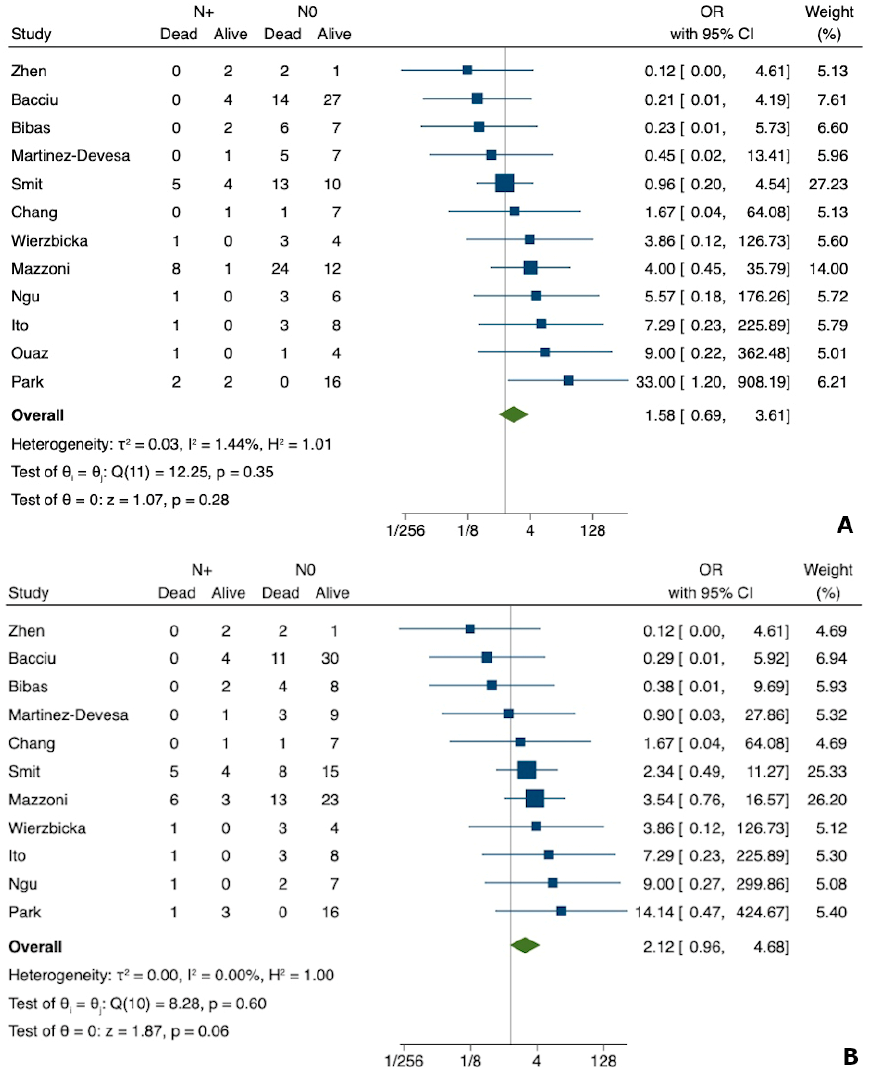
Figure 4. Forest plot for the odds ratio of N status and survival (( A )—overall survival [4,23,24,26–33,35]; ( B )—disease speci fi c survival [4,23,24,26–28,30–33,35]) in temporal bone squamous cell carcinoma of the external auditory canal.